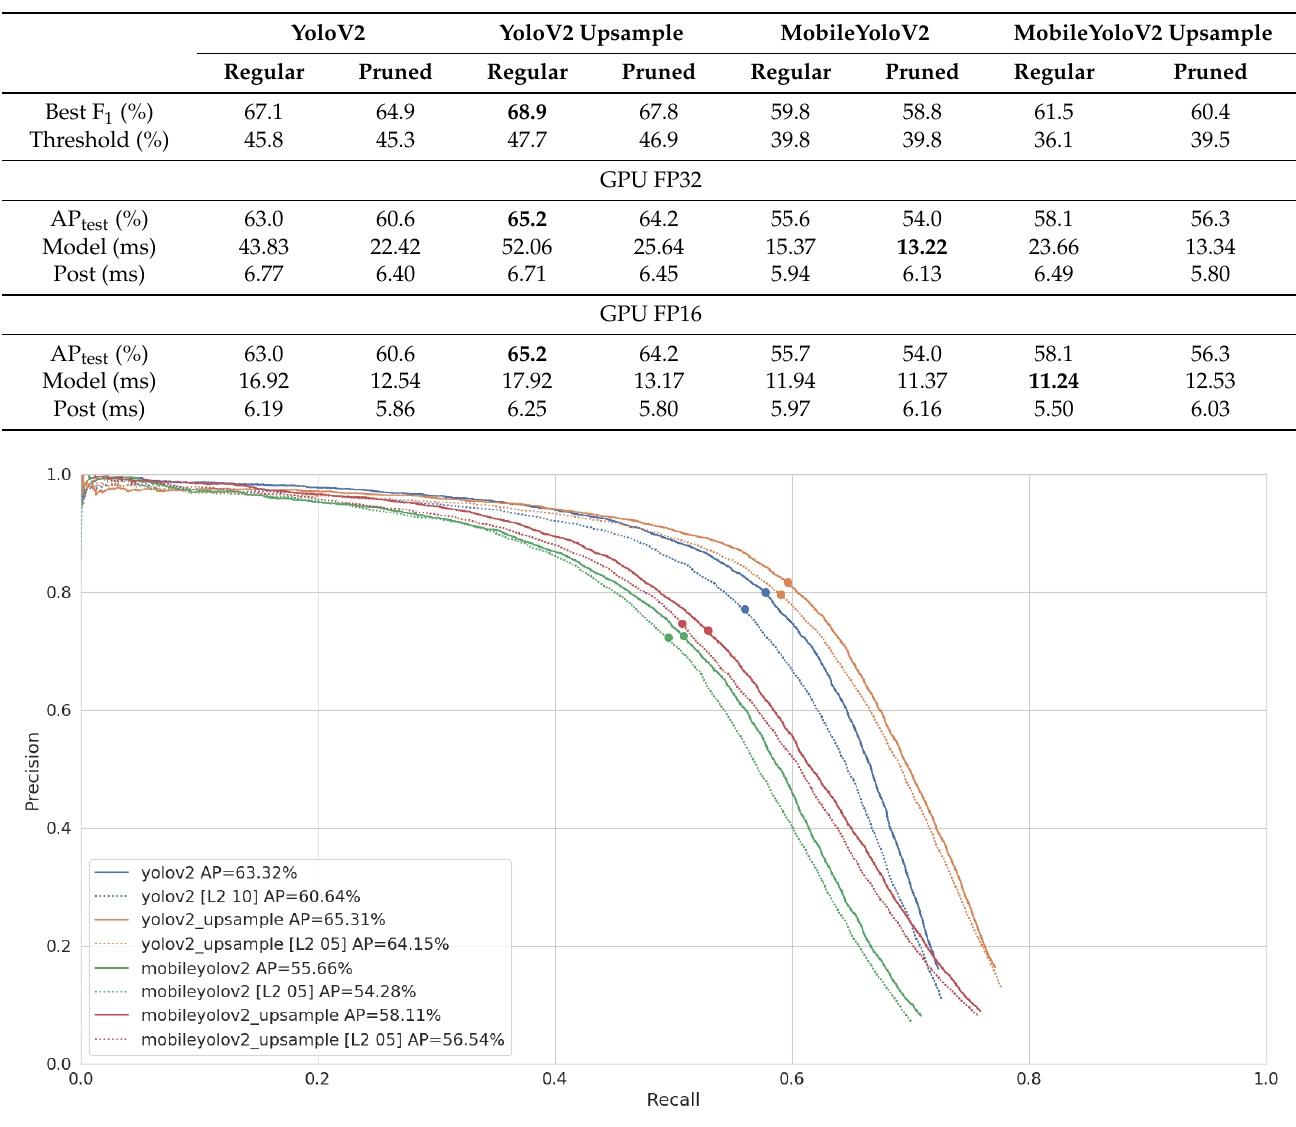
Table 5. Model accuracy and inference times measured on the NVidia Jetson Xavier and averaged over the Pascal VOC test set. Average Precision (AP) is measured with a threshold of 1% and timing results are measured with a threshold set at the best F 1 score. The best values are shown in bold.